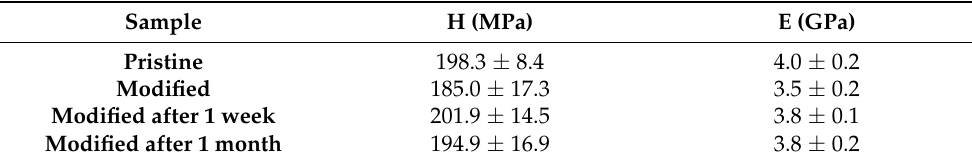
Table 1. Mechanical characterization of different